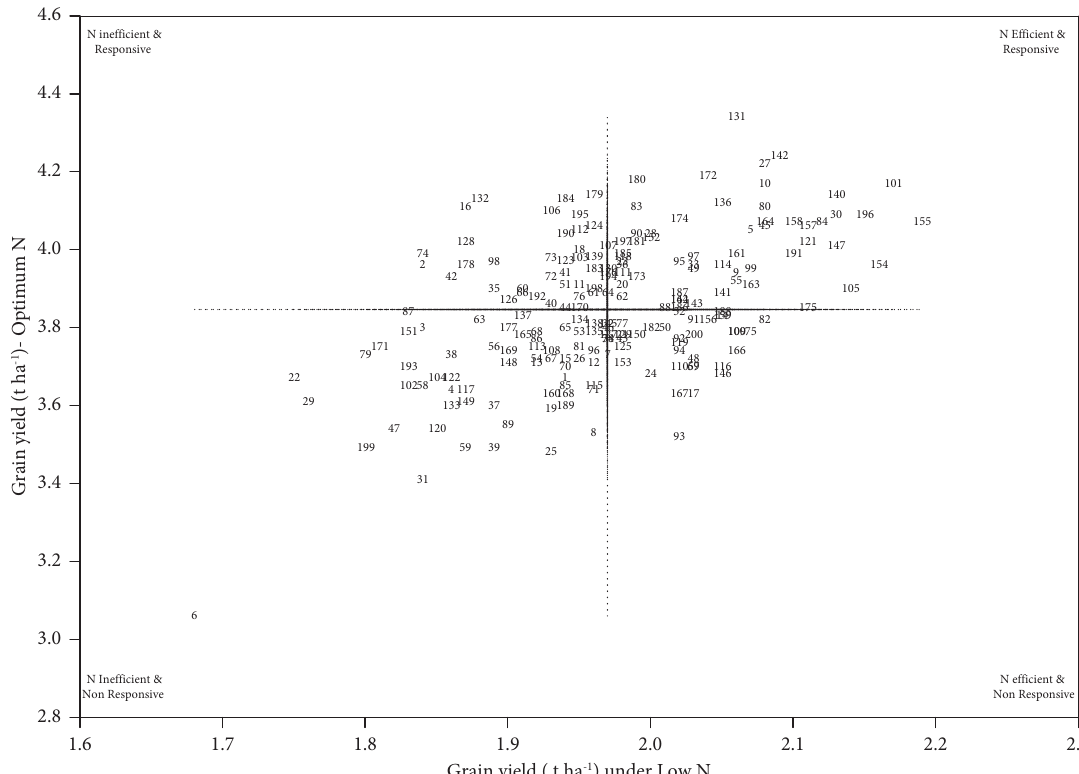
Figure 1: Categorization of durum wheat genotypes into N-efciency and N-responsive groups based on grain yield. Horizontal and vertical broken lines depict mean grain yield under low and optimum N conditions, respectively. Table 4: Summary of durum wheat genotypes classifed using multiple criteria for low-N tolerance. Parameters N-efcient genotypes